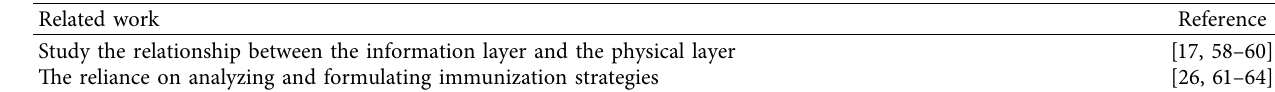
Table 3: The work done on infectious diseases using the multiplex network: in the related work column, the research studies performed by researchers using the multilayer network are shown, and in the reference column is the relevant literature of the corresponding research. Related